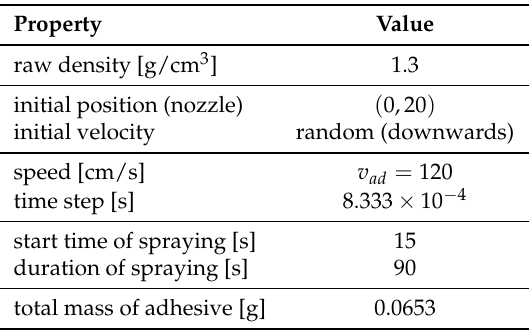
Table 2. Properties of adhesive droplets for all